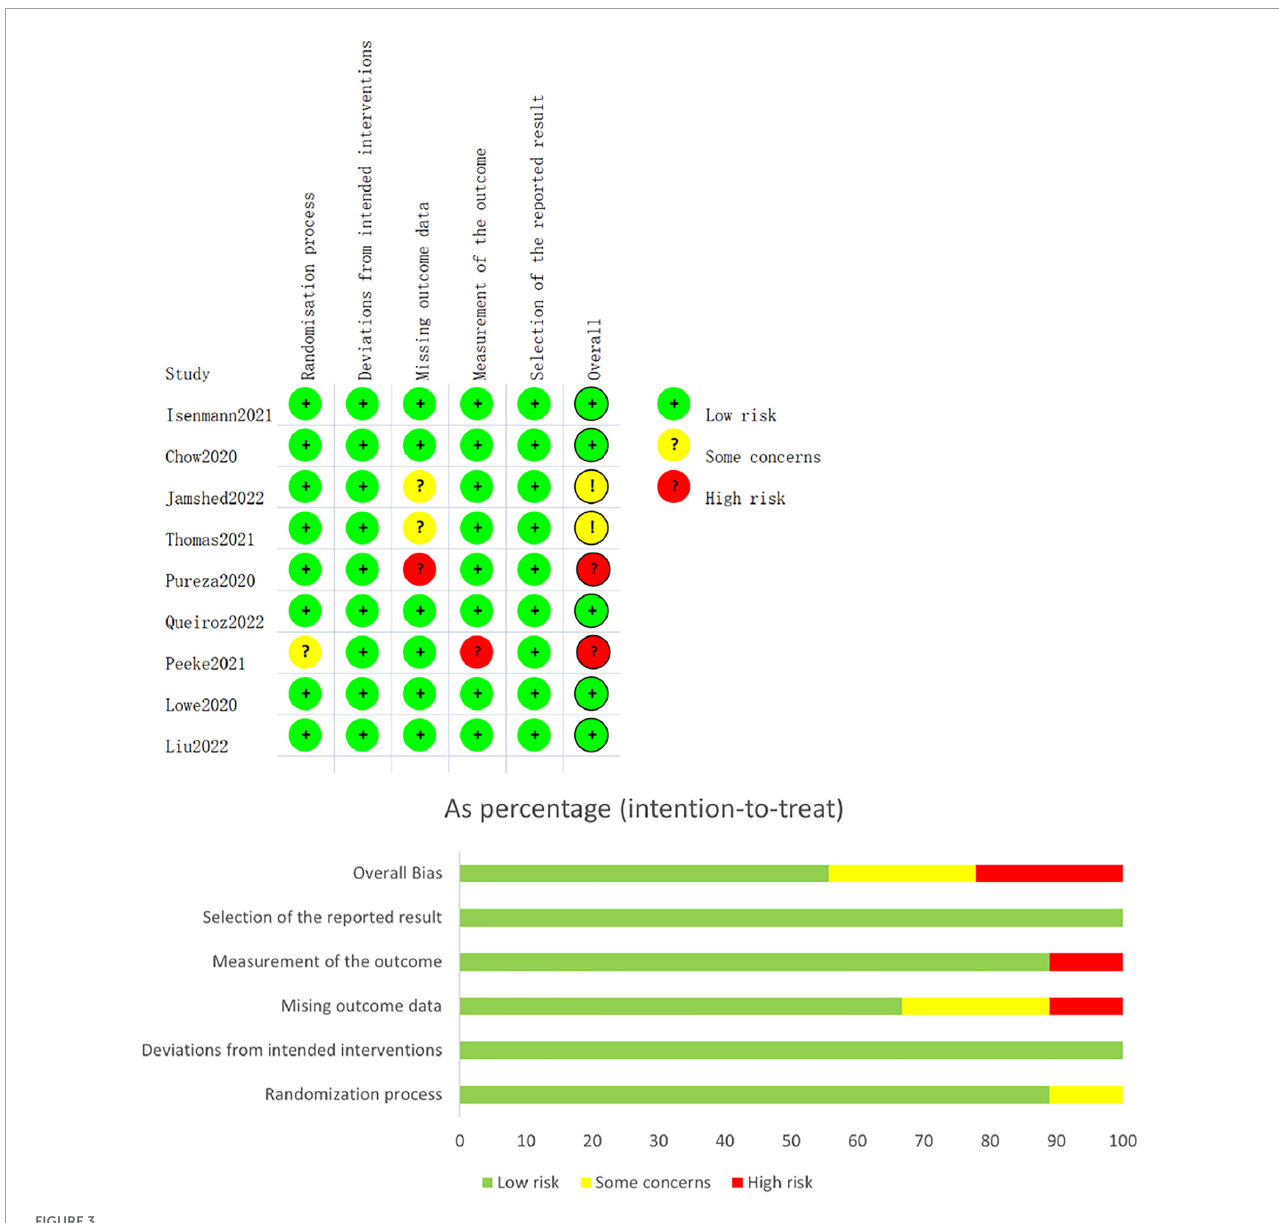
FIGURE3 Risk of bias